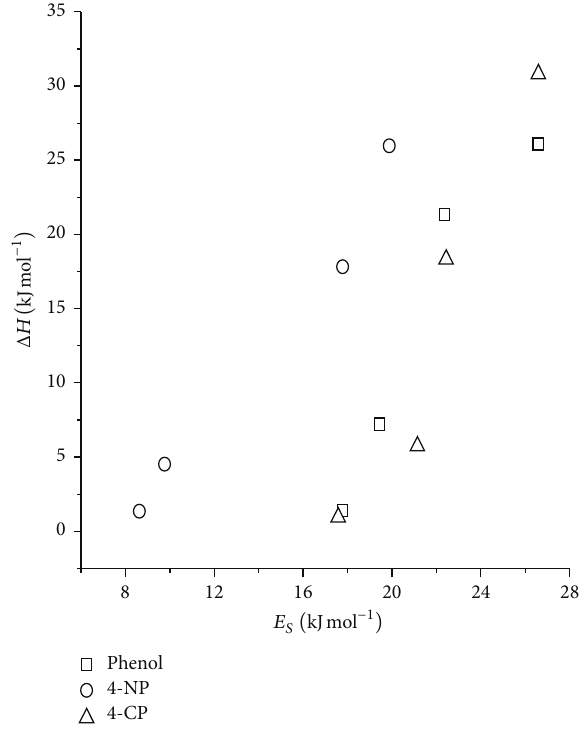
Figure5:Correlationbetweenenthalpieschangesofadsorptionand characteristics energies of phenols on